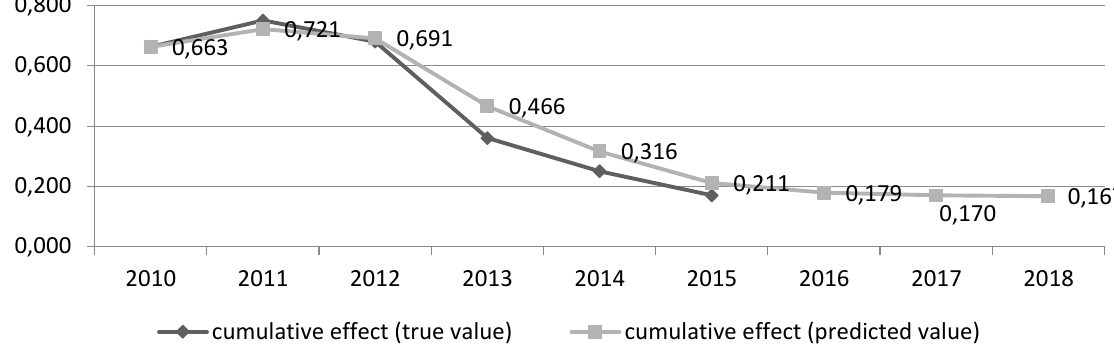
Source: produced by the